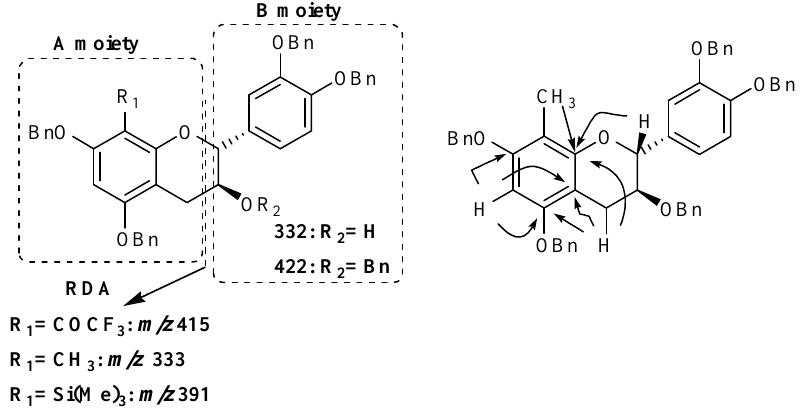
Figure 3. Main fragmentations observed in compounds 11 , 16 and 18 and main 1 H- 13 C long range correlations observed for compound 16